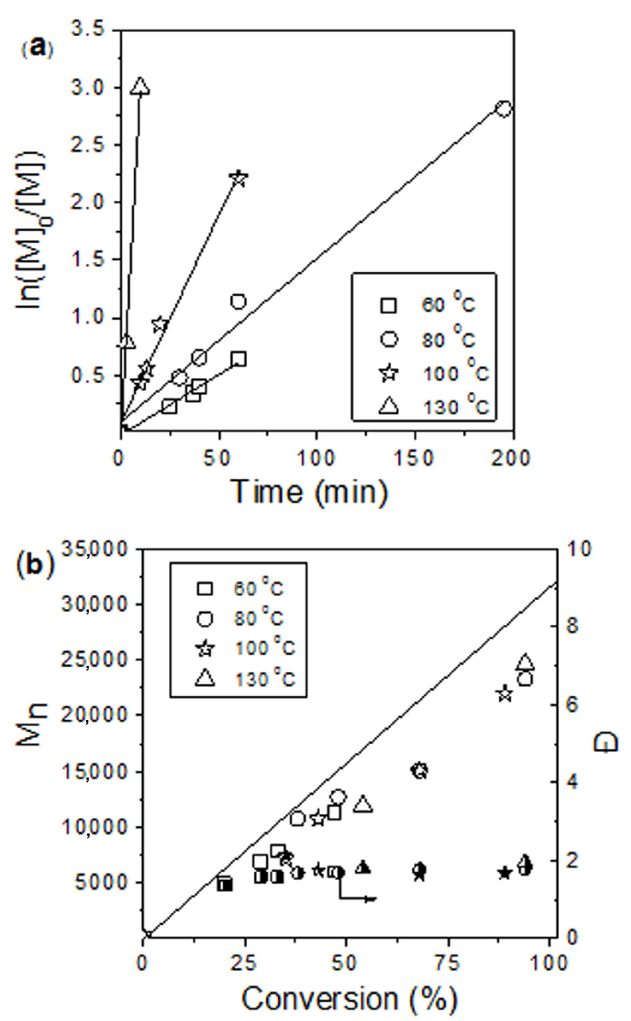
Figure 2. ( a ) ln[ M ] 0 /[ M ] vs. time; ( b ) M n , Ð vs. conversion dependences for the bulk ε -caprolactone polymerization for catalyst 3a at [ M ]/[ 3a ] = 300 and at different temperatures. The straight line in Figure 2b corresponds to the theoretical molecular weight calculated as M n (theor) = ([ ε - caprolactone]/[ 3a ]) × 114 × Conversion + 115. Experimental values of the molecular weight deter- mined by SEC versus polystyrene standards were corrected by a factor of 0.52